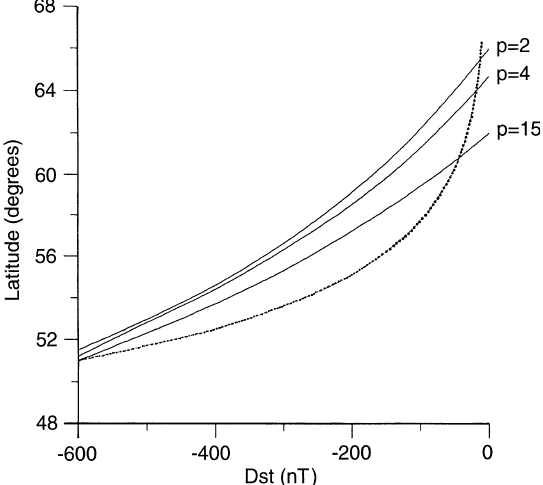
Fig. 2. Dependence of latitudes of various boundaries on the Dst index in the midnight sector. The solid lines correspond to the ionospheric projection of the contour B (cid:136) B s . The dashed line shows the storm-time behaviour of the equatorward edge of the